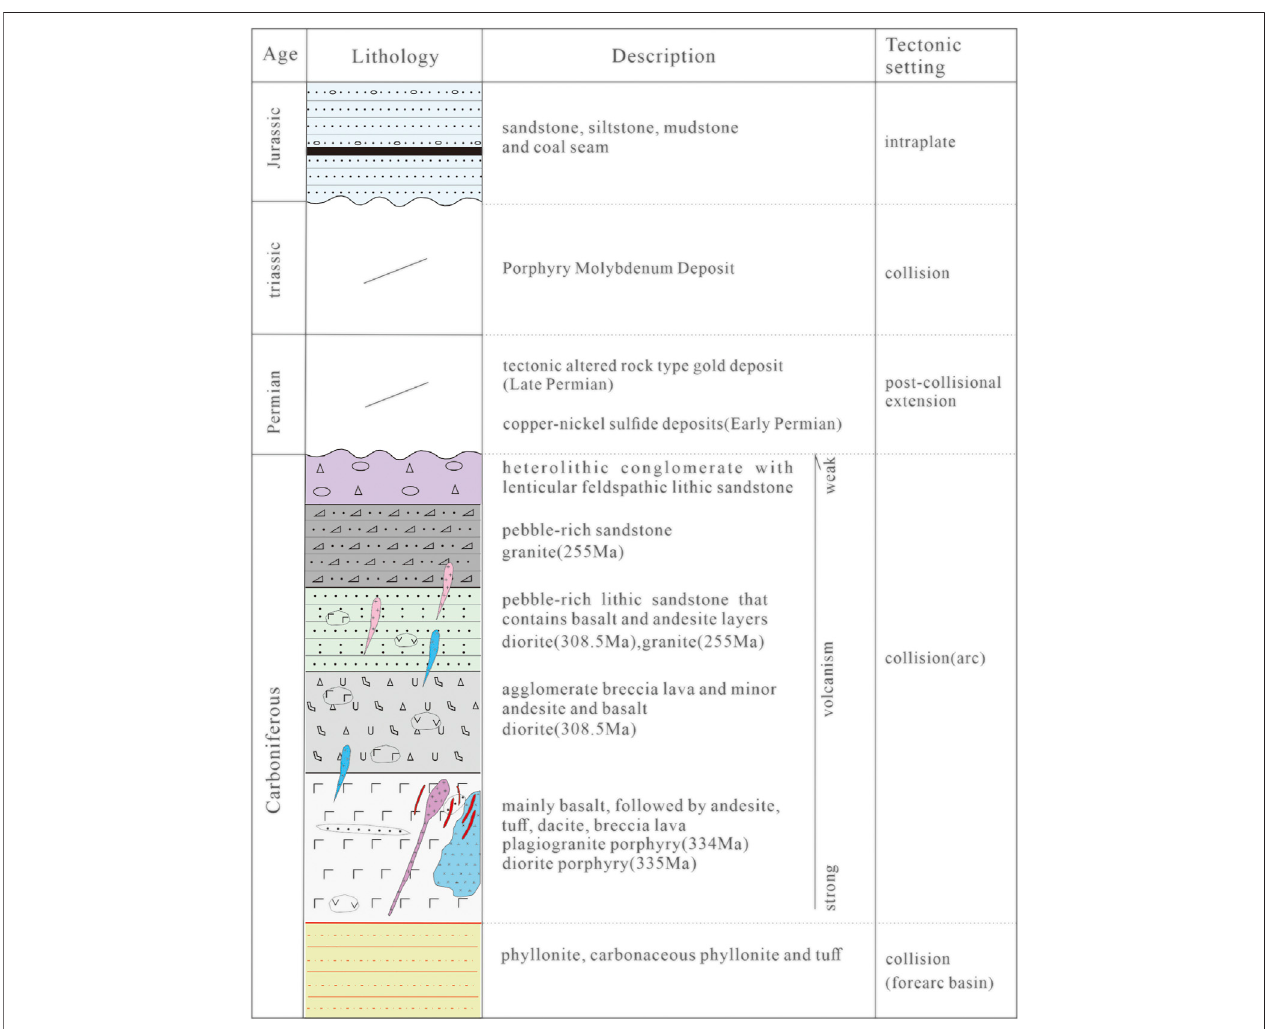
FIGURE 3 | The chronostratigraphic chart of geological events in Tuwu copper ore district.